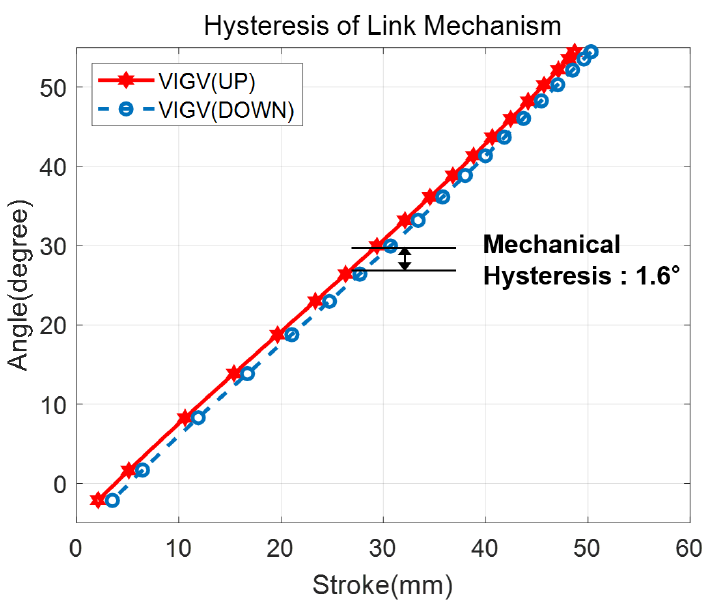
Figure 13. Mechanical hysteresis of link mechanism.